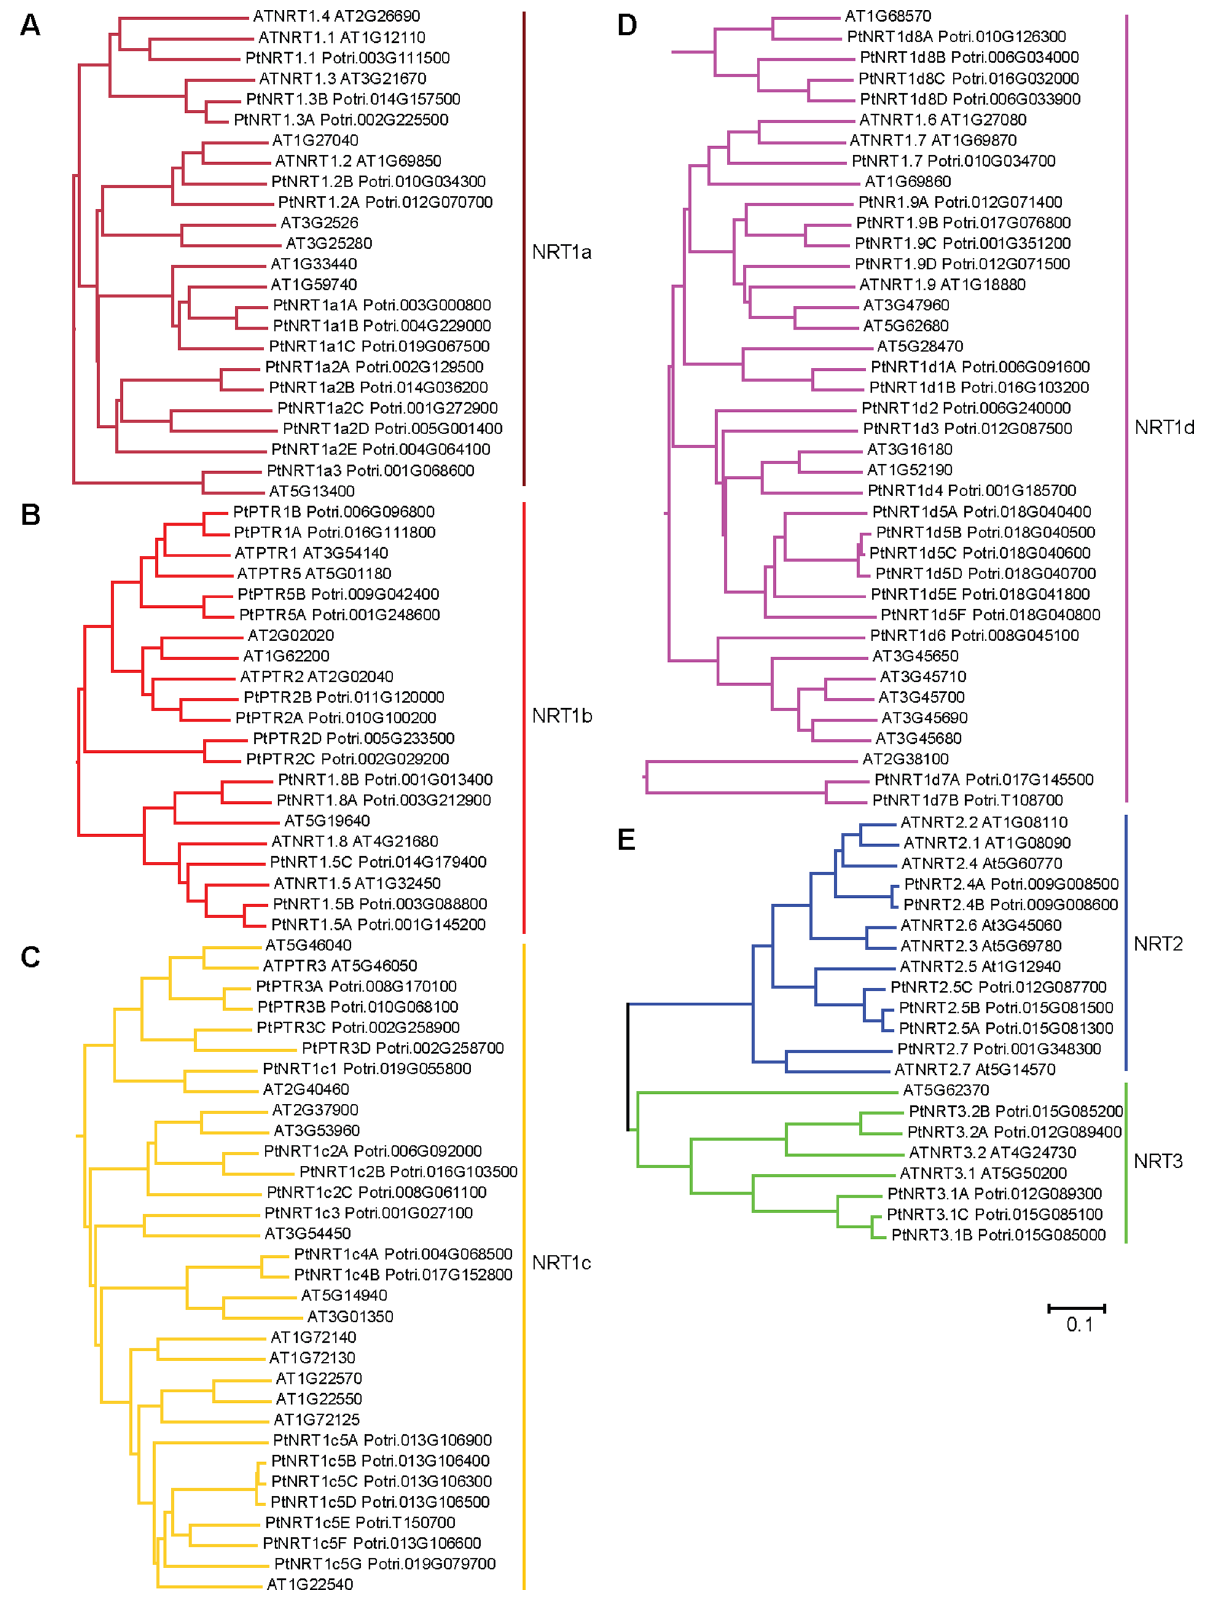
Figure 2. Expanded view of the phylogenetic relationships of the genes in the NRT families of P.trichocarpa and A.thaliana . A . subclade NRT1a. B . subclade NRT1b. C . subclade NRT1c. D . subclade NRT1d. E . clade NRT2 and NRT3. A–D represent together clade NRT1/PTR.